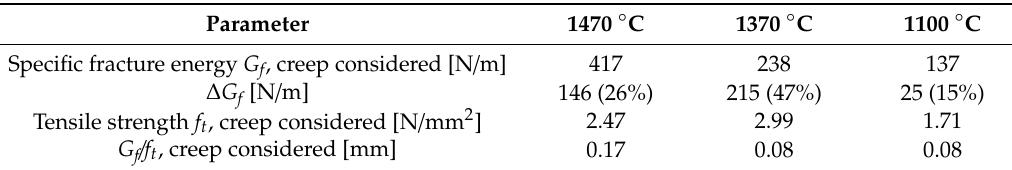
Table 3. Fracture mechanical parameters at di ff erent temperatures calculated considering creep and influence on G f . Parameter Specific fracture energy G f , creep considered [N / m] Tensile strength f t , creep considered [N / mm 2